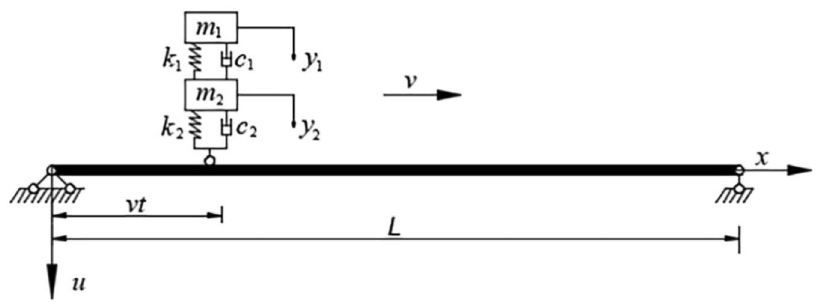
Figure 1. Beam subjected to a moving